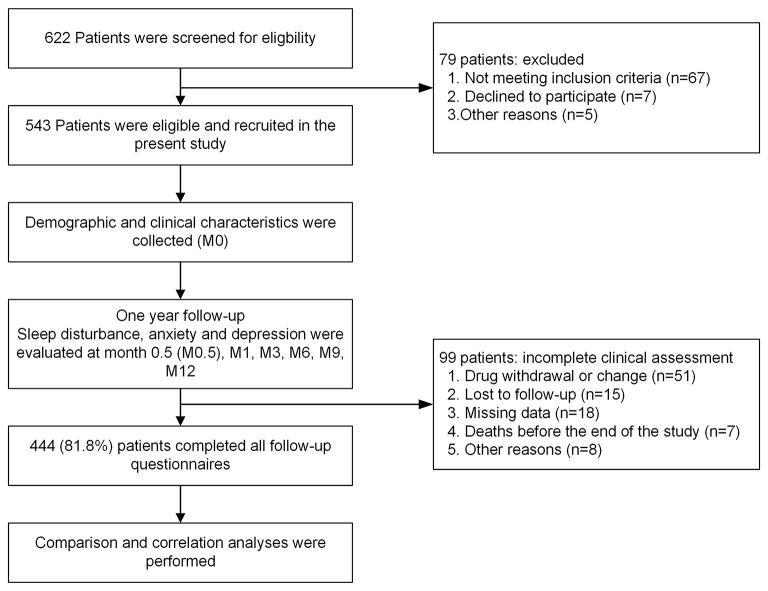
Flow chart of subject enrolment.